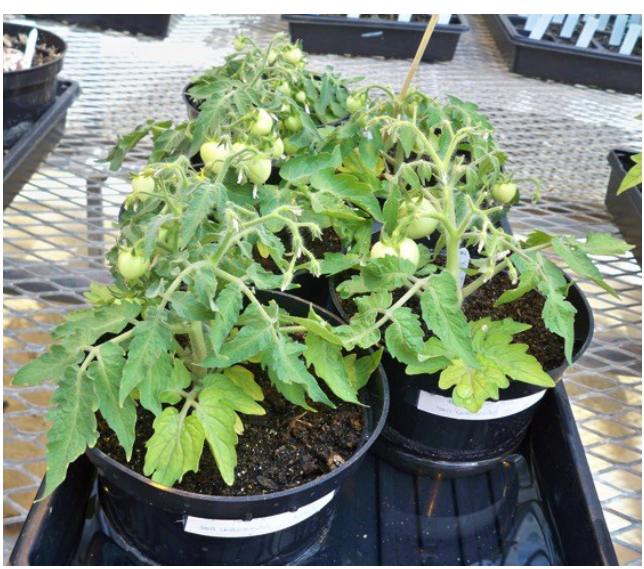
Figure 4. Micro-Tom plants that had been seed-contaminated with E. coli O157:H7-GFP.